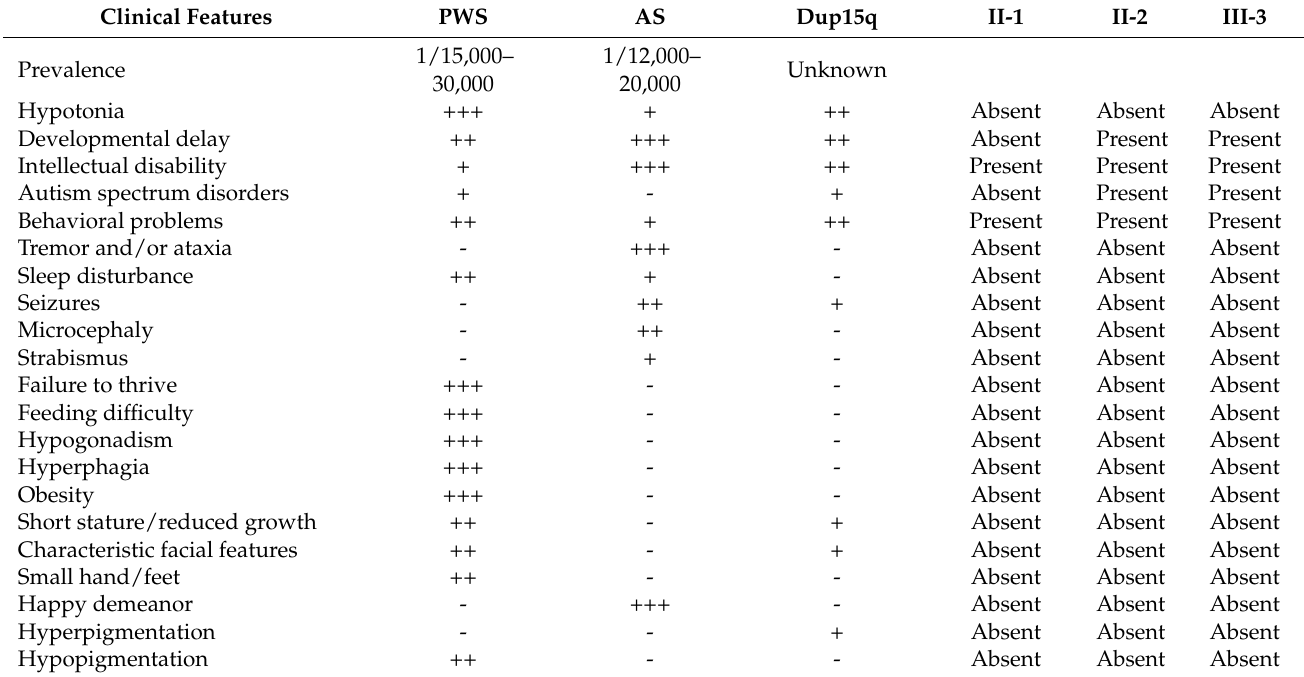
Table 1. Comparison of clinical features of Prader–Willi, Angelman, and 15q11.2-q13.1 duplication syndromes and our patients [14–21].